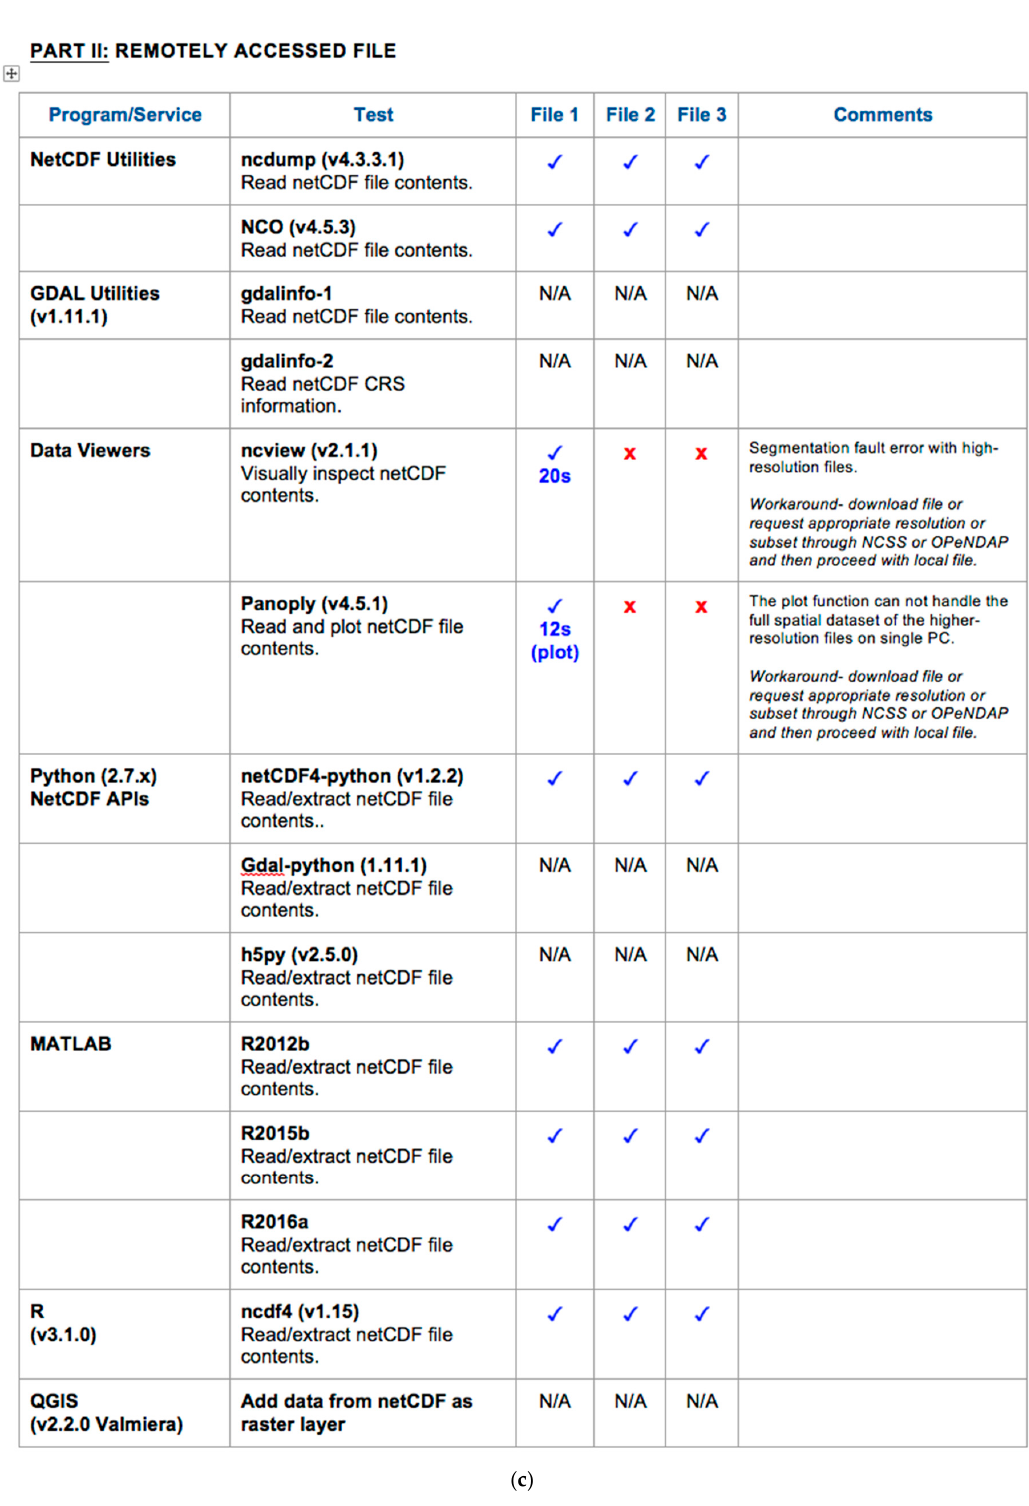
Figure A2. An example of NCI functionality QA test report. ( a ) The first section of the report provides a short summary of results and whether the data is considered functional with all the tested tools, and lists the details of the files that were used for the assessment, including the properties of the files, such as size, variable shape, chunk size, and compression (deflate) level. ( b ) The second section provides the results for the functionality tests performed on the data, directly on the filesystem. ( c ) The third section provides the results of the functionality tests using the data served through NCI’s THREDDS